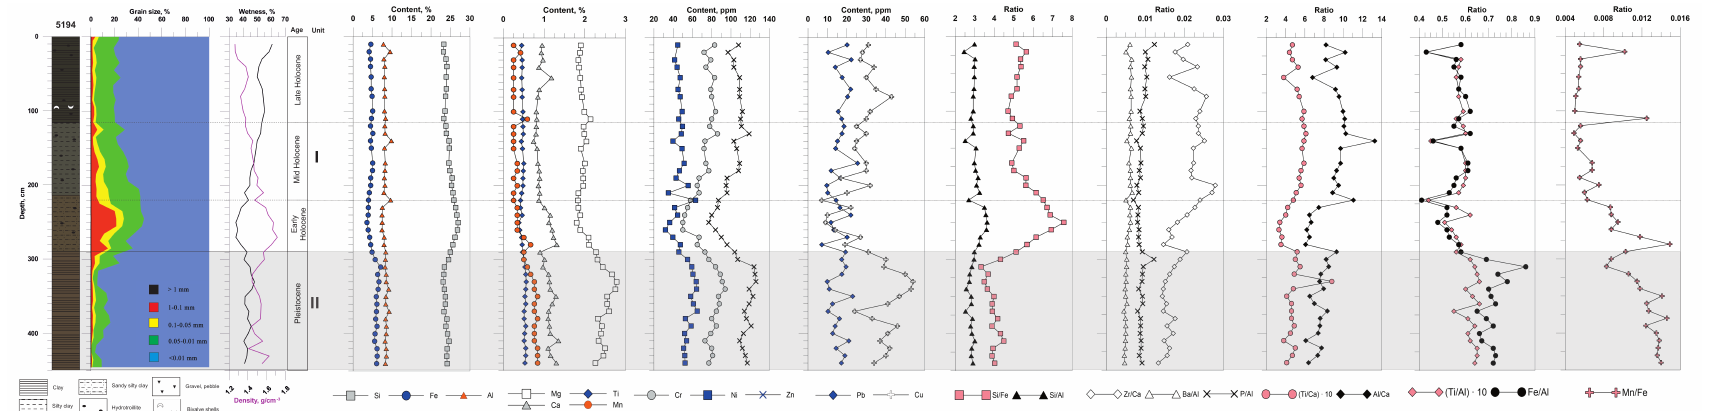
Figure 9. Lithology and variations of Si, Al, Fe, Ca, Mg, Ti, Mn, heavy metals Cr, Zn, Ni, Cu, and Pb, as well as elemental ratios in core AMK-5194, the Central Deep of the Barents